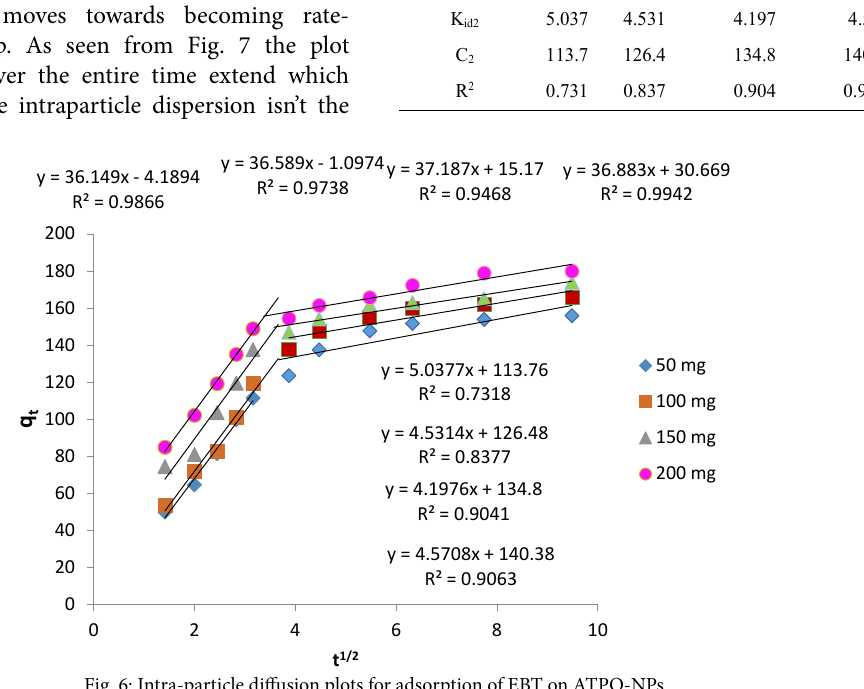
Fig. 2: Plot of concentration (ppm) Vs Time (min) 0 2 468 1012